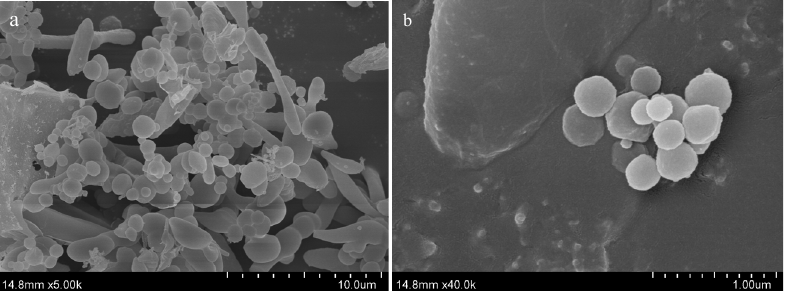
µ m; ( b ) the field of view at 1 µ